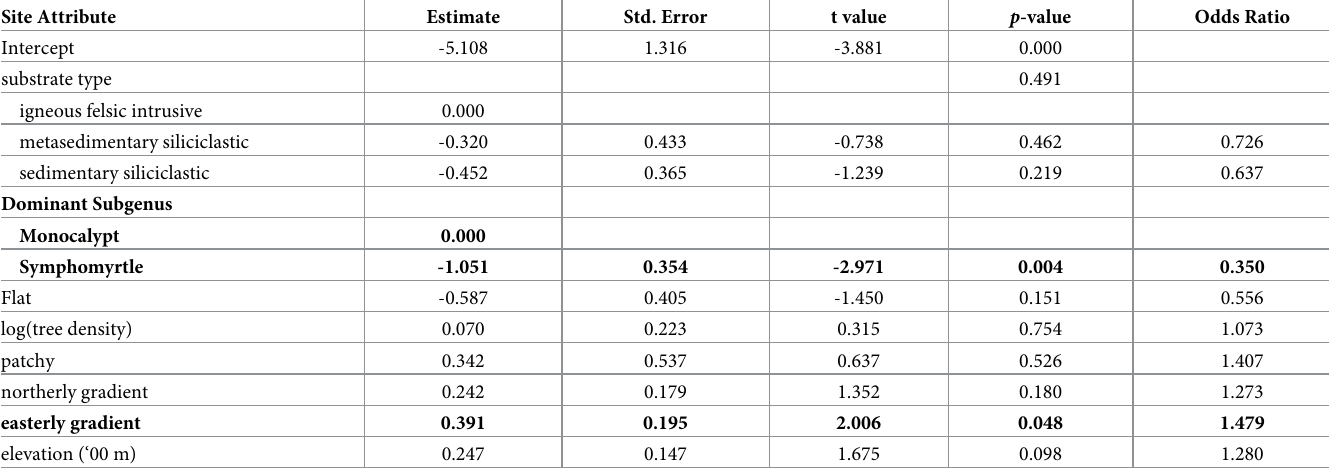
Table 1. Fitted beta-binomial regression model with dependent variable the number of chewed trees of any level of chewing at a site.